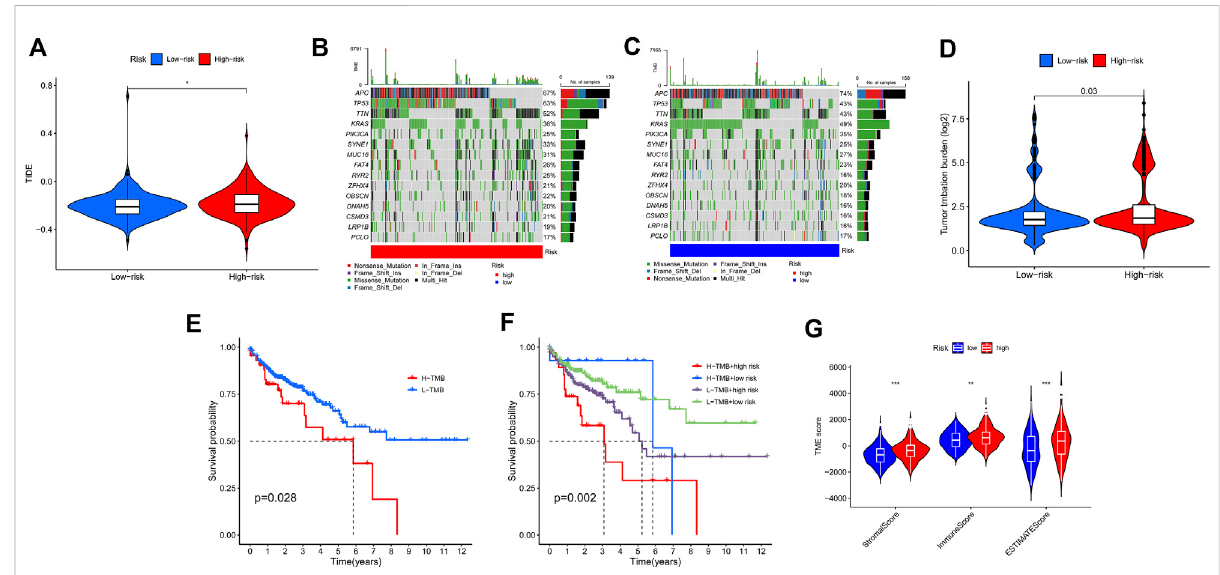
FIGURE 9 Estimation of the tumor immune microenvironment and cancer immunotherapy response using the ferroptosis-associated gene signature in the TCGA entire set. (A) TIDE prediction difference in the high- and low-risk patients. (B,C) Waterfall plot displays mutation information of the genes with high mutation frequencies in the high-risk group (B) and low-risk group (C) . (D) TMB difference in the high- and low-risk patients. (E) Kaplan- Meier curve analysis of OS is shown for patients classi fi ed according to the TMB status. (F) Kaplan-Meier curve analysis of OS is shown